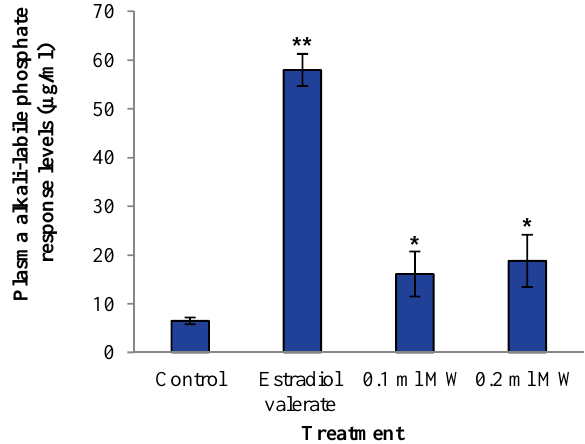
Figure 3. Plasma alkali-labile phosphate levels in immature common carp treated with estradiol valerate and different concentrations of municipal wastewater for 21 days (mean ± SD) (n = 9) Asterisk (*) indicates that the di ff erence between the experimental and control groups was significant at P < 0.05